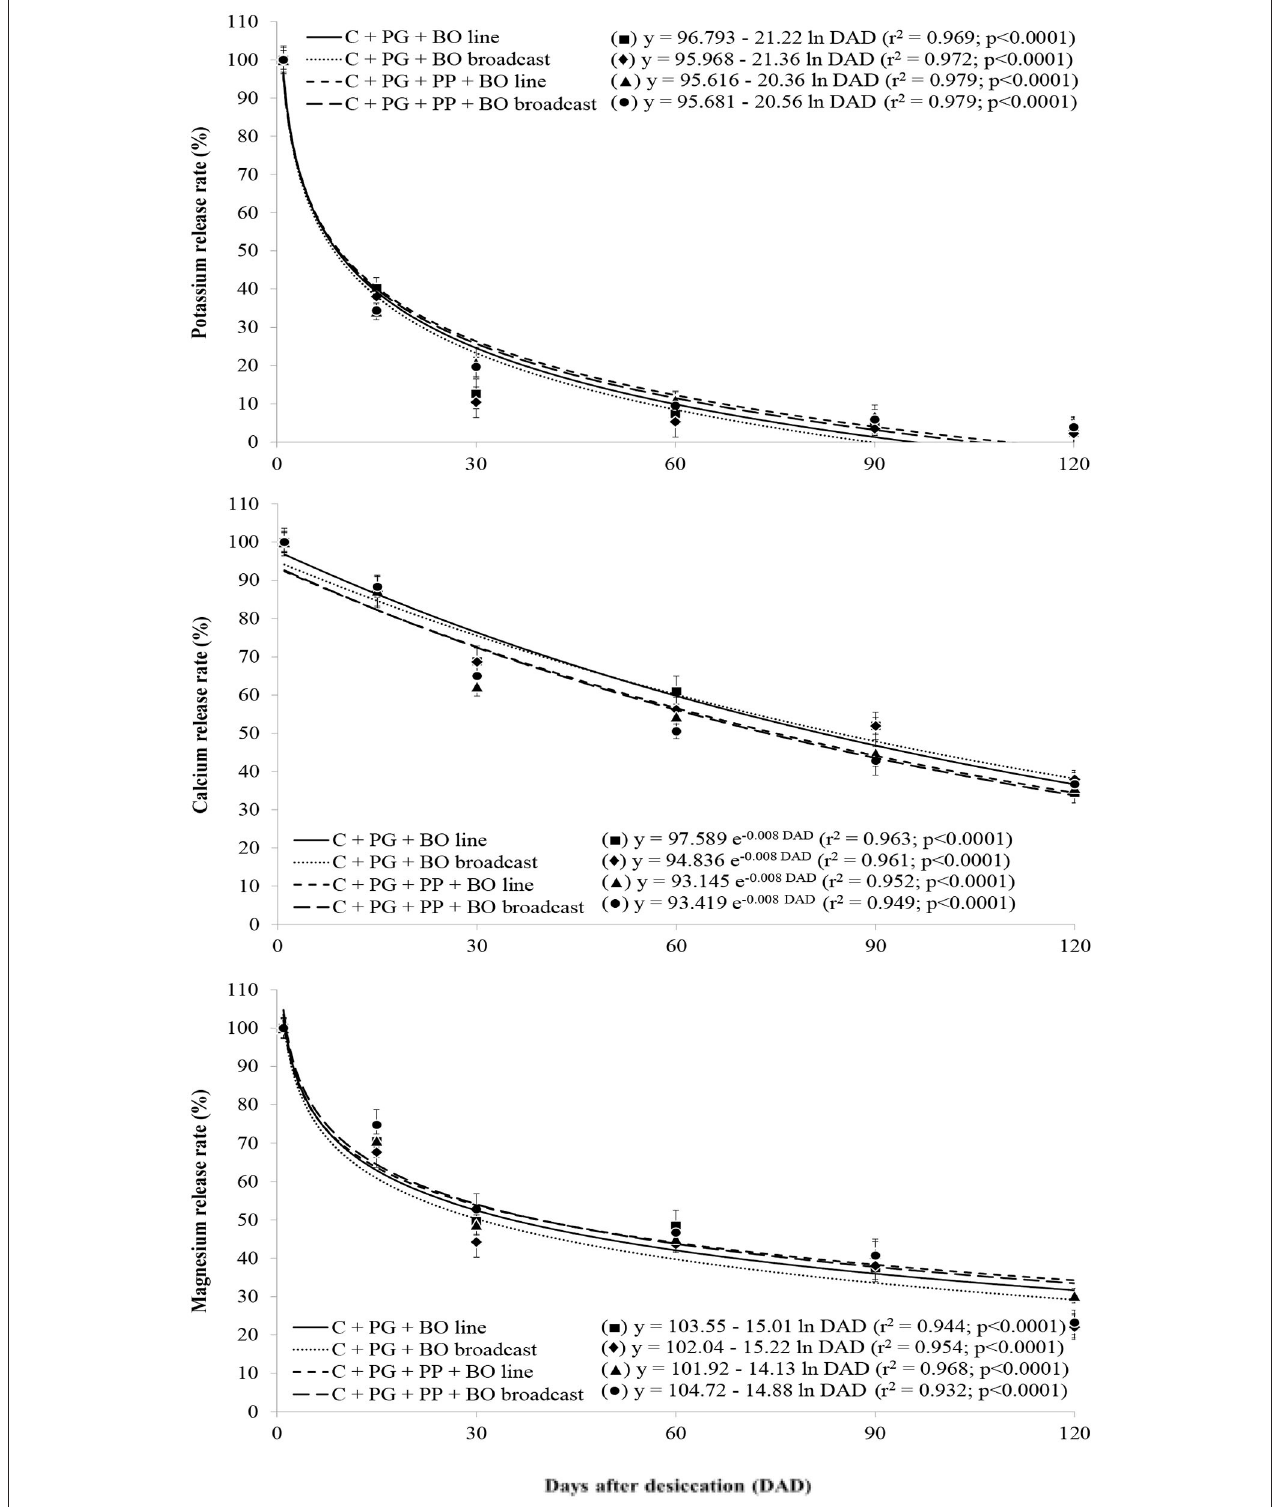
FIGURE 2 | Release rate of potassium, calcium, and magnesium in palisade grass (PG) intercropped with corn (C) and with corn and pigeon pea (PP) to silage with black oat (BO) oversown in lines and broadcast after grazing by lambs as a function of days after desiccation (mean of three growing seasons). Values are the mean of 12 replicates, and the associated error bar is ± 1 SE. Days after desiccation (DAD): days after pasture and weed desiccation with glyphosate herbicide, after grazing by lambs.